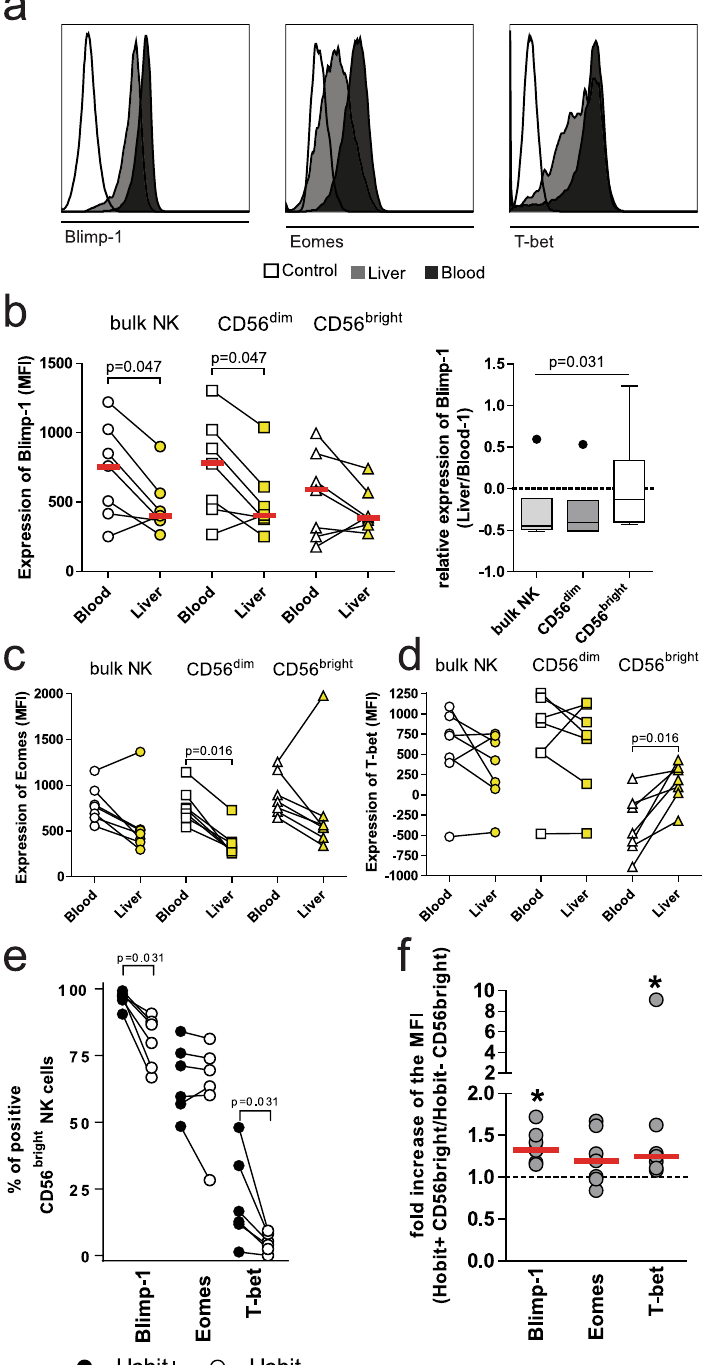
Figure 4. Altered expression of transcriptions factors in Hobit pos CD56 bright liver NK cells. ( a ) Histogram showing expression of Blimp-1 (left panel), Eomes (middle panel) and T-bet (right panel) on bulk NK cells in the blood (dark grey) compared to the liver (light grey) and a FMO control (white). ( b ) Expression (left panel) of Blimp-1 on bulk, CD56 dim and CD56 bright NK cells in the peripheral blood (open symbols) and liver (yellow symbols). Ratio of the expression (right panel) of Blimp-1 in each subset between Liver and Blood. ( c ) Expression of Eomes on bulk, CD56 dim and CD56 bright NK cells in the blood (open symbols) and liver (yellow symbols). ( d ) Expression of T-bet on bulk, CD56 dim and CD56 bright NK cells in the blood (open symbols) and liver (yellow symbols). ( e ) Frequency of Blimp-1 pos , Eomes pos and T-bet pos cells among CD56 bright liver NK cells comparing Hobit pos (black symbol) with Hobit neg (open symbol). ( f ) Fold change of the expression (MFI) of Blimp-1, Eomes and T-bet on CD56 bright liver NK cells comparing Hobit pos with Hobit neg cells. Wilcoxon matched pair sign rank test was used to determine statistical differences in the scatter plots and Friedman test was used for box